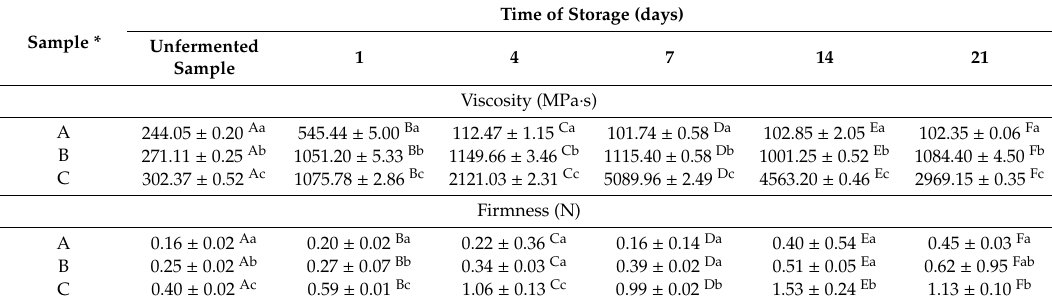
Table 4. Viscosity and firmness of fermented beverages and unfermented (control)